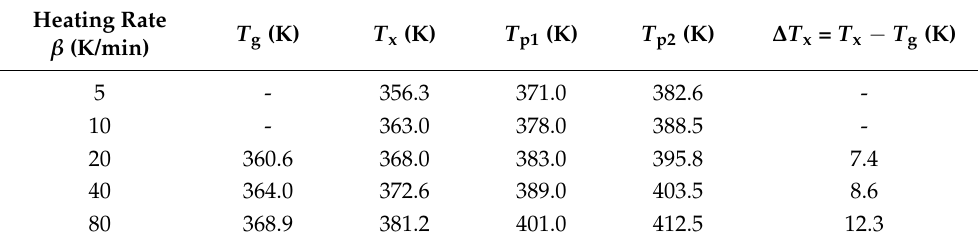
Figure 4. DSC curves for the amorphous Mg 72 Zn 28 alloy heated at the rate of 5 K/min, 10 K/min, 20 K/min, 40 K/min, and 80 K/min. Table 1. Characteristic temperatures: T g , T x , T p, and undercooling degree ∆ T x for amorphous Mg 72 Zn 28 alloy heated at different rates.